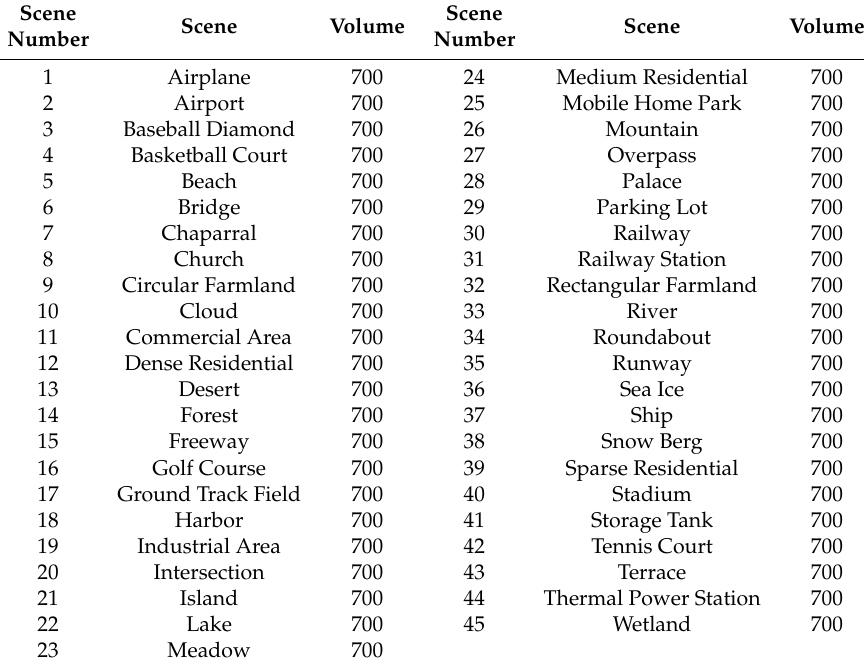
Table 3. Names and volume of different scenes in NWPU